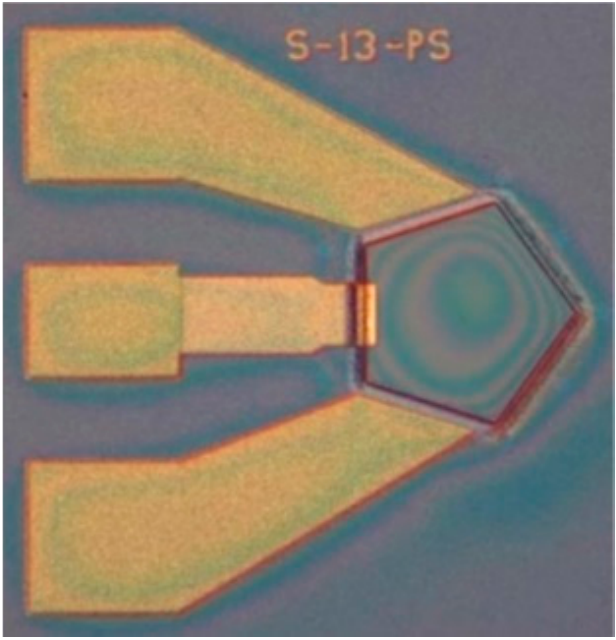
Figure 13. Optical image of the ME antenna. The test platform is shown in Figure 14.